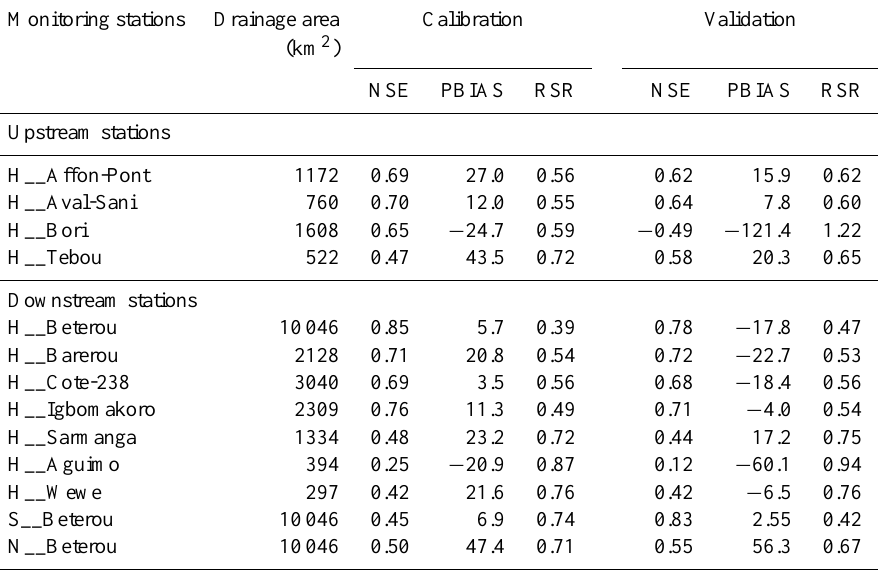
Table 4. Calibration and validation results for streamflow, sediment and organic nitrogen loads (Prefix H__ indicates results for streamflow calibration and validation; prefix S__ indicates results for sediment load calibration; N__ indicates results for organic nitrogen load calibra- tion). NSE is Nash–Sutcliffe efficiency, PBIAS is percent bias, and RSR is the ratio of the root mean square error to the standard deviation of measured